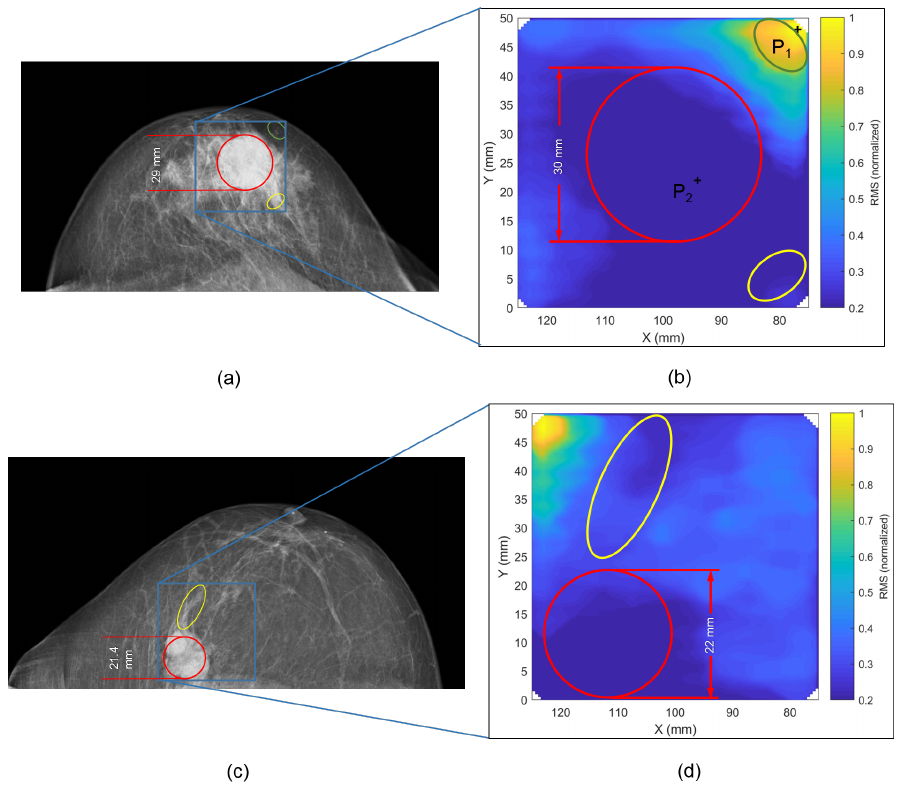
Figure 2. Comparison between X-ray image and microwave image for patient A ( a , b ) and patient B ( c , d ). The RMS was normalized by the maximum RMS of the scanned region of the present patient. The lowest intensity values occur in the area of the tumor location given by stronger attenuation of cancerous tissue. The final thickness of the compressed breast during microwave examination is very similar for patients A and B, i.e., 4.4cm for patient A and 4.3cm for patient B. During X-ray examination, the breast was slightly more compressed, i.e., 4.1cm for patient A and 3.7cm for patient B.